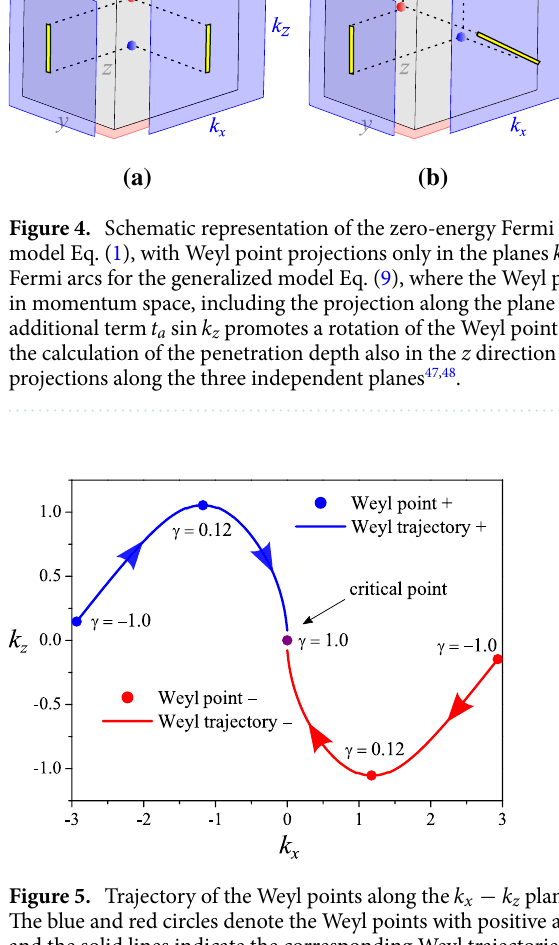
0.0 states obtained numerically by diagonalization of the Hamiltonian of Eq. (9), for a lattice with 800 sites, γ = and open-boundary conditions for one direction at a time, see Fig. 10 (refer to ’Methods’ section for details). Physically, the term that distinguishes between Eqs. (1) and (9) restores the penetration depth of the surface state along the z direction with open-boundary conditions. Thereby, the projection of the Weyl points can be found in all planes. The collision between the Weyl points, as the control parameter γ changes, occurs in the plane 0 (into the bulk), that contains simultaneously the red and blue spheres in Fig. 4. k x k z for k y − = k z shown in Fig. 4b, we track in Fig. 5 the To better understand the trajectory of the Weyl points in plane k x − 1 . These points reaarange their trajectories, path followed by each of these points until the critical point at γ = such that they can collide along the k z direction. In order to characterize the topological phases and the topological phase transitions, we use the invariant sector Chern numbers 51,52 C ( k x ) , C ( k y ) and C ( k z ) . This invariant is given by C ( k µ ) = are the orthogonal directions to the µ , ǫ µ , ν , τ is the Levi-Civita antisymmetric tensor and BZ denotes the Brillouin ( C ( k x ) , C ( k y ) , C ( k z )) . In our Zone. The topological phases are distinguished by the Chern numbers, C = 0, 1, 1 , see Fig. 6. Fig- case, depending on γ , k x , k y and k z the sector Chern number can be equal to C ( k µ ) = − 1 (non-trivial), the gray ure 6a,b show three different topological regions, the blue region possesses C ( k z ) = 1 (non-trivial) and the white region has C ( k z ) 0 (trivial). region C ( k z ) = − = Note that, in Fig. 6 the edges of the region blue in Fig. 6a and the region gray in Fig. 6b correspond to the coordinates of k z and k x , respectively, of the Weyl points for each fixed γ . Accordingly, the projection of these coordinates on the surface delimits the Fermi arc extension, as represented in Fig. 4. Therefore, the topological regions in Fig. 6 are intimately related with the existence of the surface states. For instance, the surface states